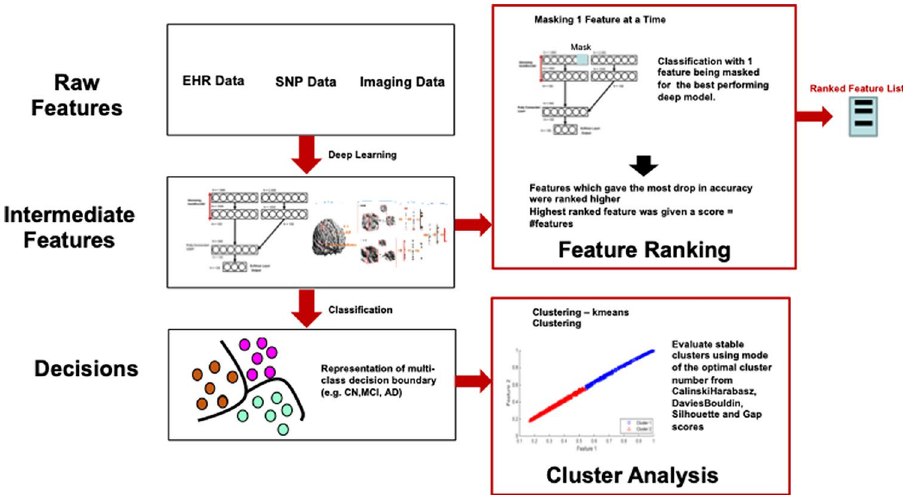
Figure 6. Feature extraction for deep model interpretation. Novel feature interpretation methodology where features are masked one at a time and the effect on the classification is observed. The feature which gives the highest drop in accuracy is ranked the highest. Once we ranked the features, we checked if the intermediate features picked associations different from raw data using cluster analysis. Deep models show associations which are different from shallow models, which accounts for superior